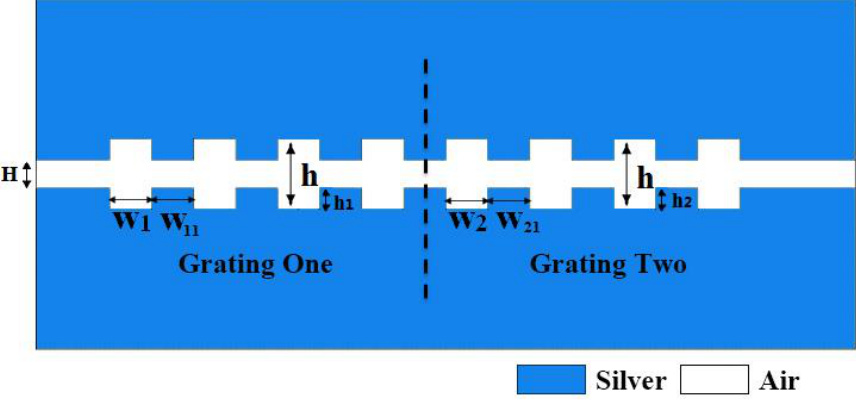
Figure 1. The structure of the MIM plasmonic Bragg grating.